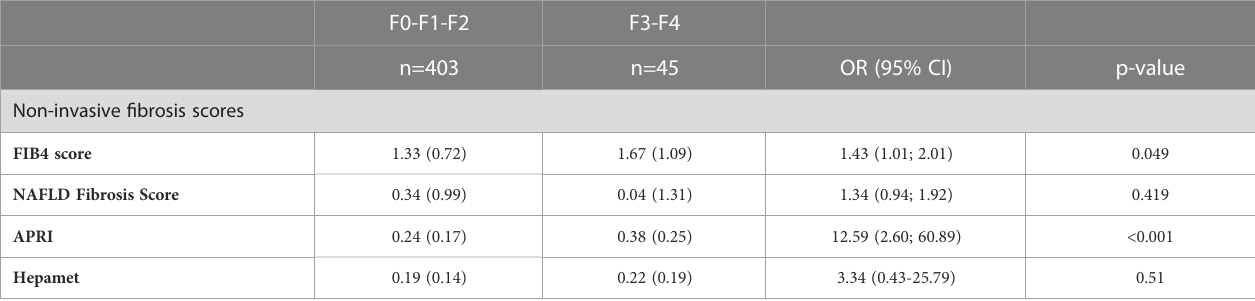
TABLE 4 Results of noninvasive fi brosis scores compared to TE.